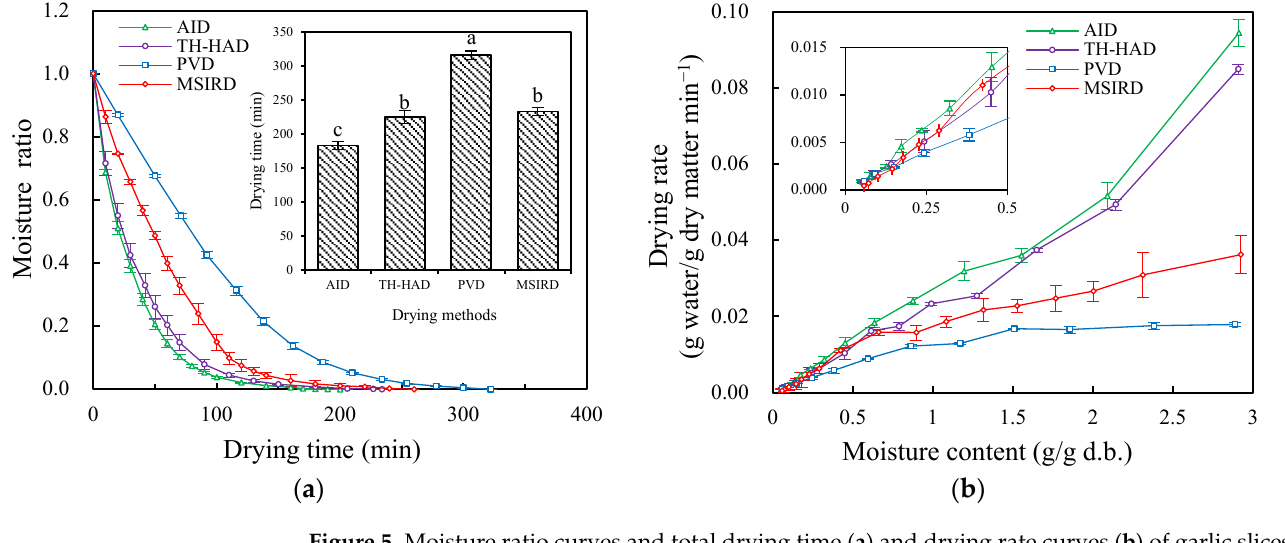
Figure 5. Moisture ratio curves and total drying time ( a ) and drying rate curves ( b ) of garlic slices under different thermal drying methods. The different letter (a–c) indicates statistically significant difference at p < 0.05.